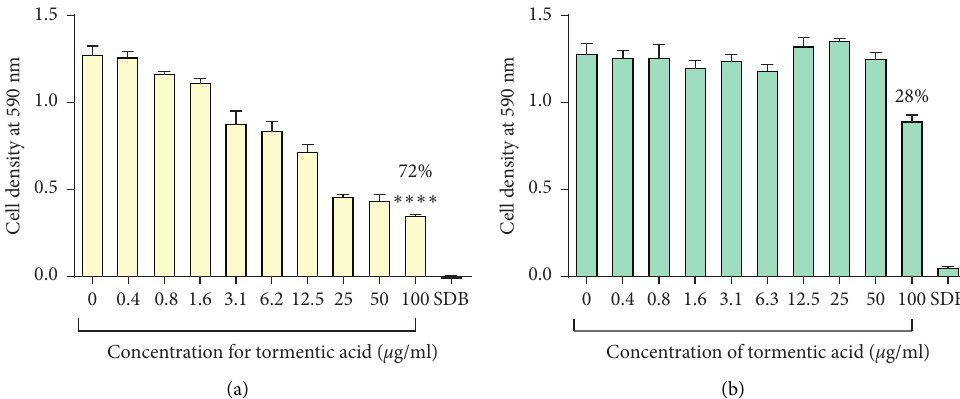
Figure 7: The effect of tormentic acid the growth of C. albicans (a) and C. tropicalis (b). The graph shows a dose-dependent decrease in cell density as the concentration of tormentic acid was increased. Percentage inhibition of 72% and 28% was observed at 100 μ g/ml for C. albicans and C. tropicalis, respectively. These data represent a mean of four replicates. The data were analysed by one-way ANOVA and Dunnett’s test for multiple comparisons. Mean values were statistically compared to the negative control (SDB). Error bars indicate standard deviation; ∗∗∗∗ p < 0 . 00001.